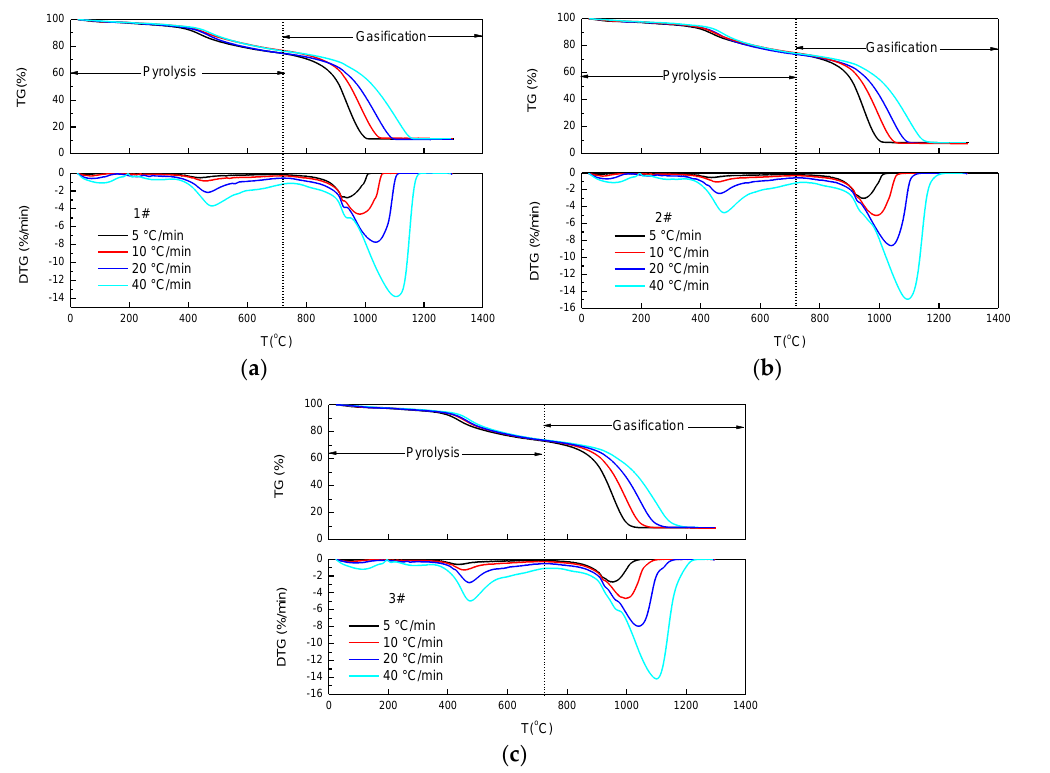
Figure 2. TG and DTG curves of coal samples under different heating rates: ( a ) 1#, ( b ) 2#, and ( c ) 3#.